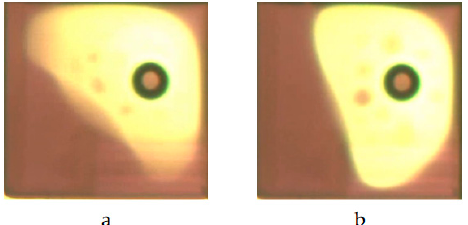
Figure 12. Gray-scale stability comparison between PWM modulation and amplitude–frequency mixed modulation. ( a ) First gray scale; ( b ) Second gray scale; ( c ) Third gray scale; ( d ) Fourth gray scale.